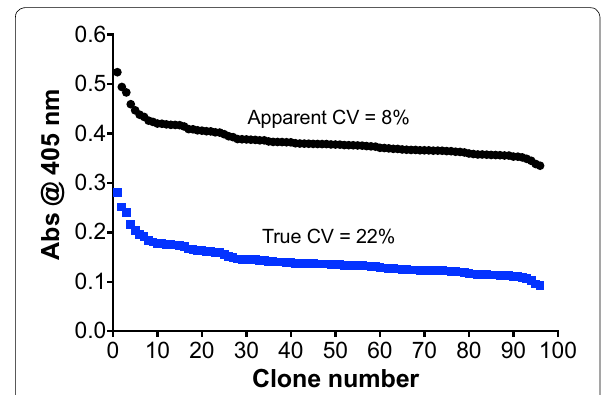
Fig. 1 Activity values (Abs 405 ) of OsmY‑DyP4‑catalysed ABTS oxidation in a 96‑well plate, reported in a descending order (black— before background subtraction, blue—after background subtraction). The assay was conducted using a protocol streamlined with OsmY‑based BENNY. The apparent coefficient of variance (CV) was calculated without subtracting the assay background, while the true CV was obtained after background